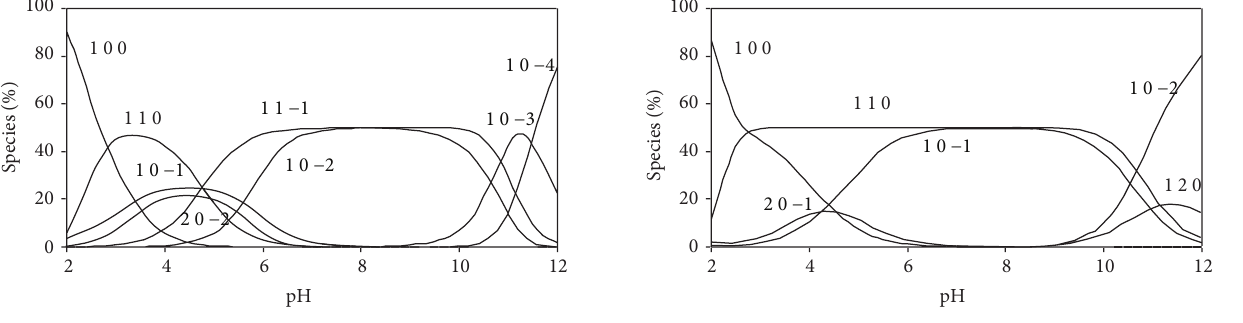
Figure 2: Concentration distribution of various species as a func- tion of pH in the dibutyltin(IV) complexes (at concentrations of 1.25 mmole/liter for DBT and 2.5mmole/liter for BIMP) at 25 ∘ C.